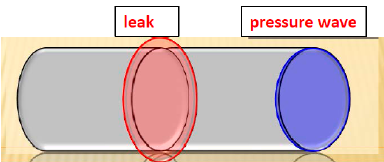
Figure 1. Displaying leakage and pressure wave.